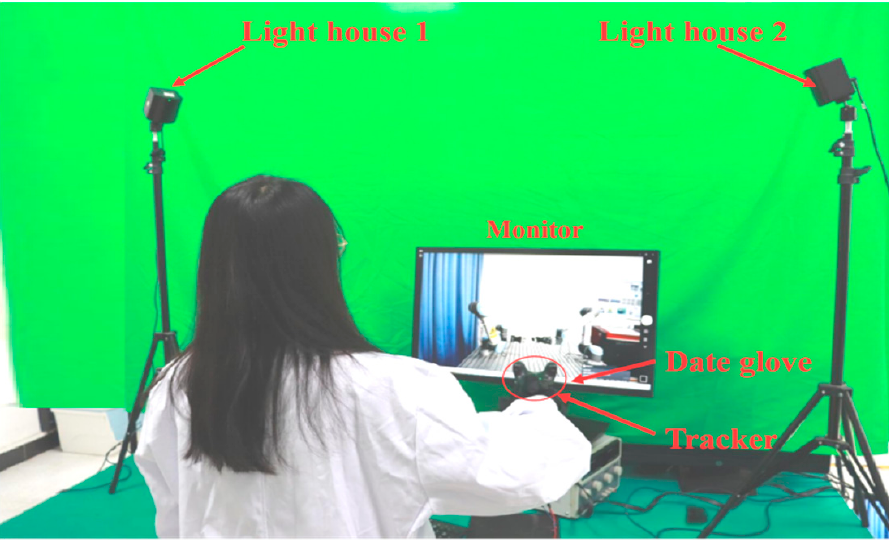
Figure 2. Human hand–arm tracking.